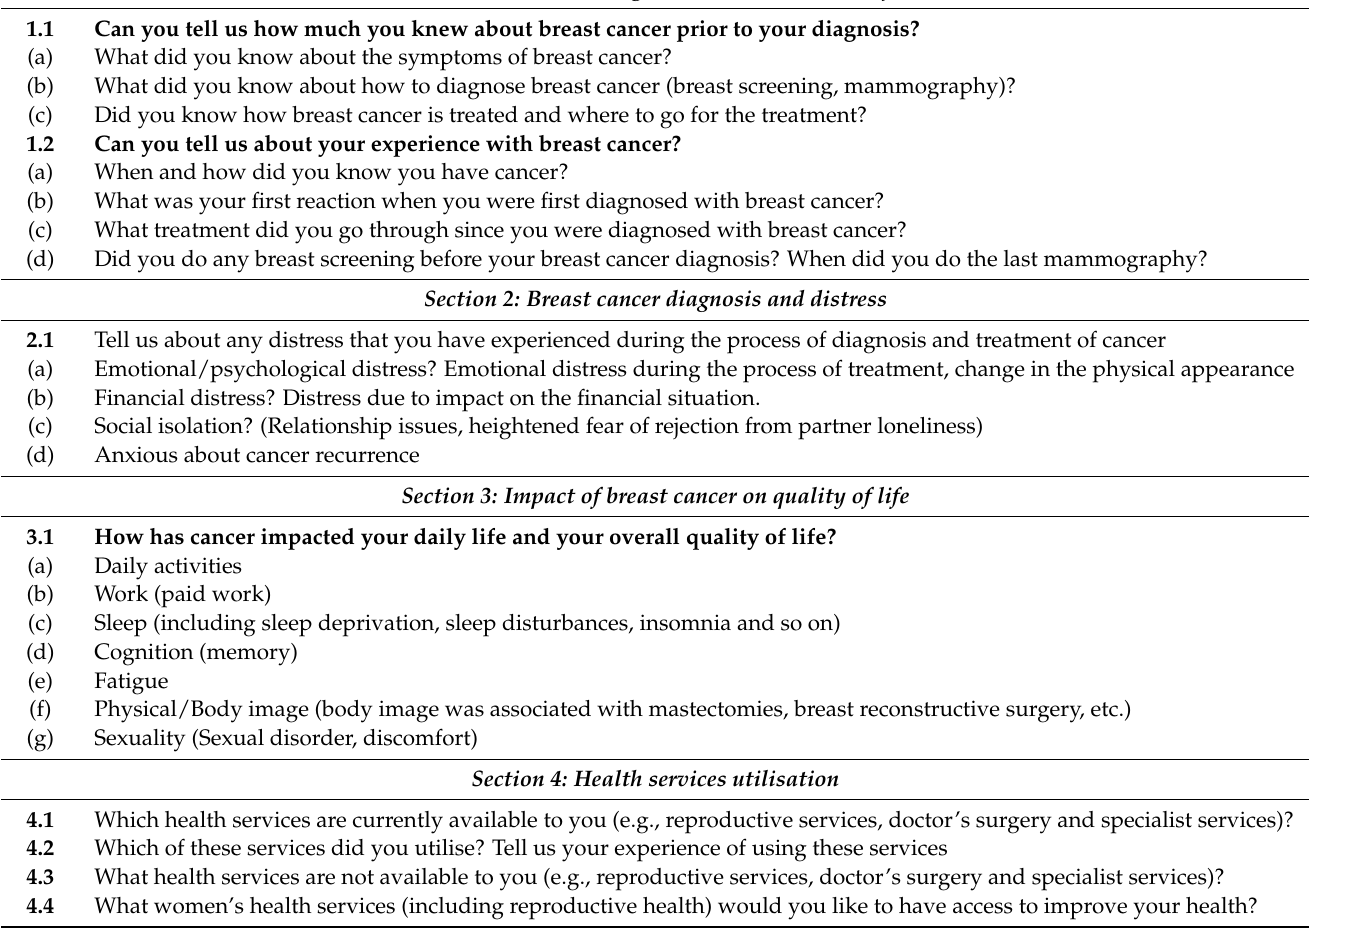
Section 1: Breast Cancer Diagnosis: Treatment and Experience